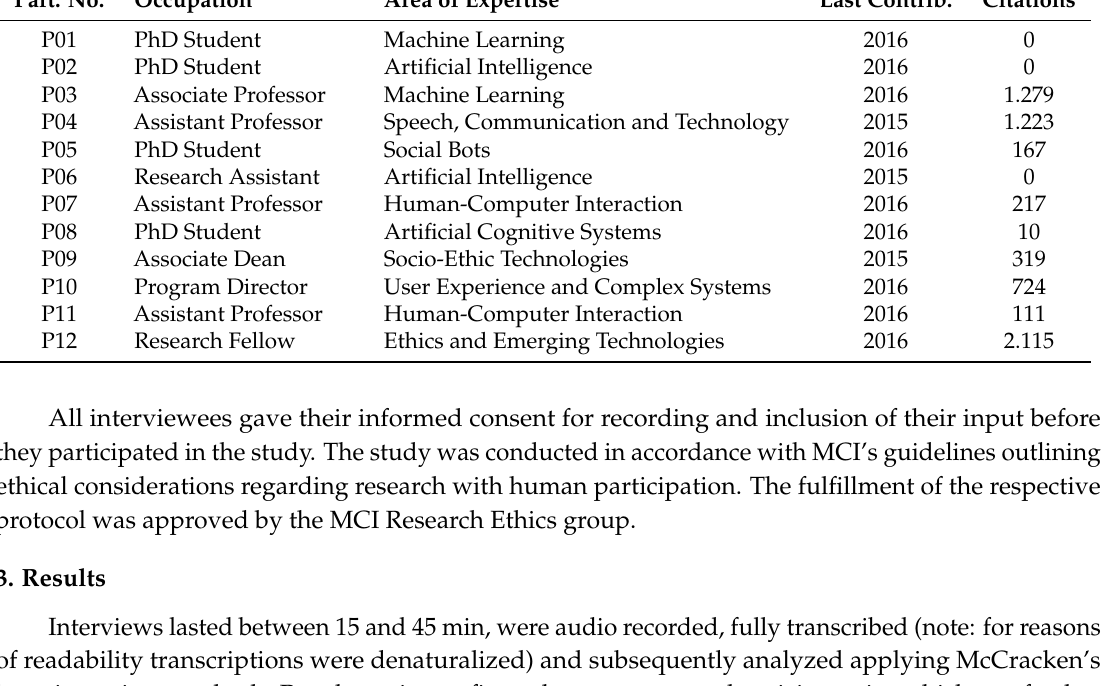
Table 1. Interview participants and their respective areas of expertise. Part.